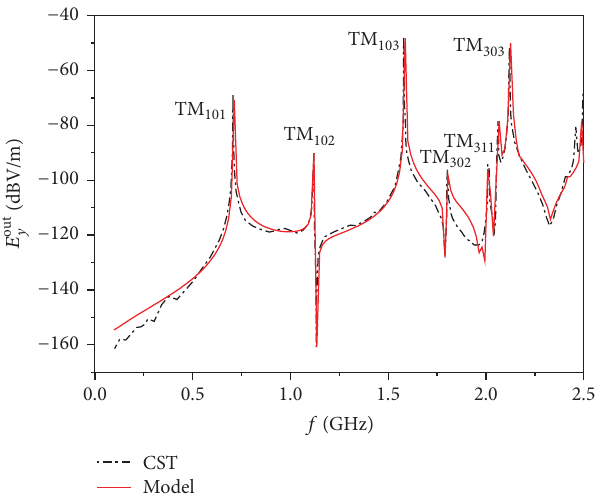
Figure 13: Electric current induced at termination load 𝑍 1 from the analytical model and the